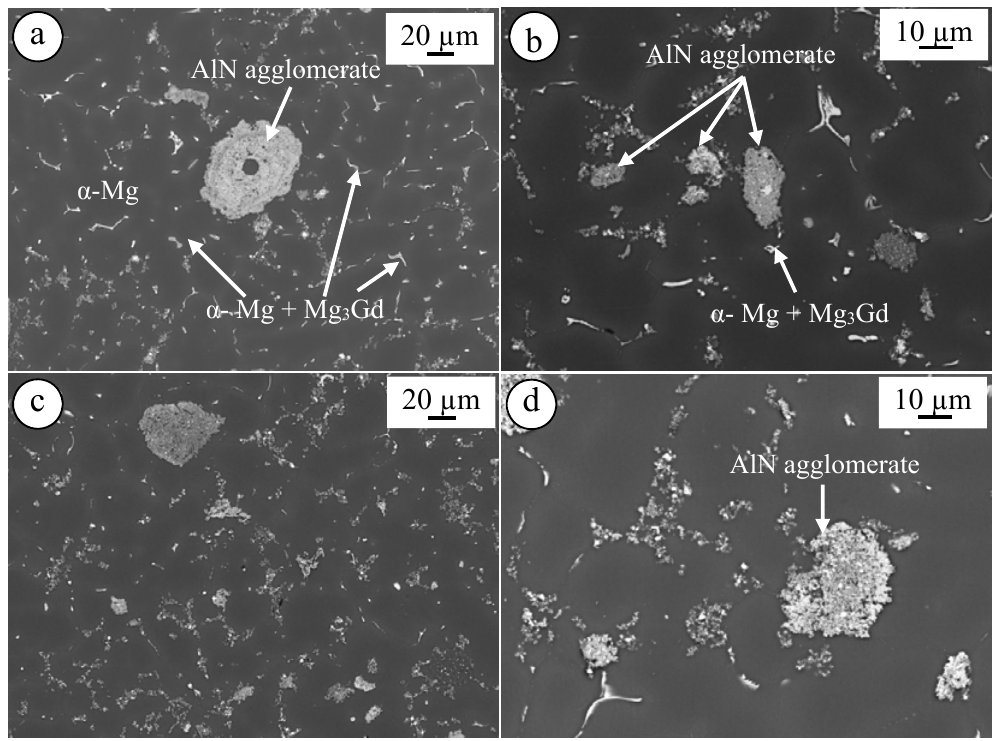
Figure 9. SEM images of as ‐ cast: ( a , b ) El21–1.0 wt.% AlN; and ( c , d ) El21–2.0 wt.% AlN.